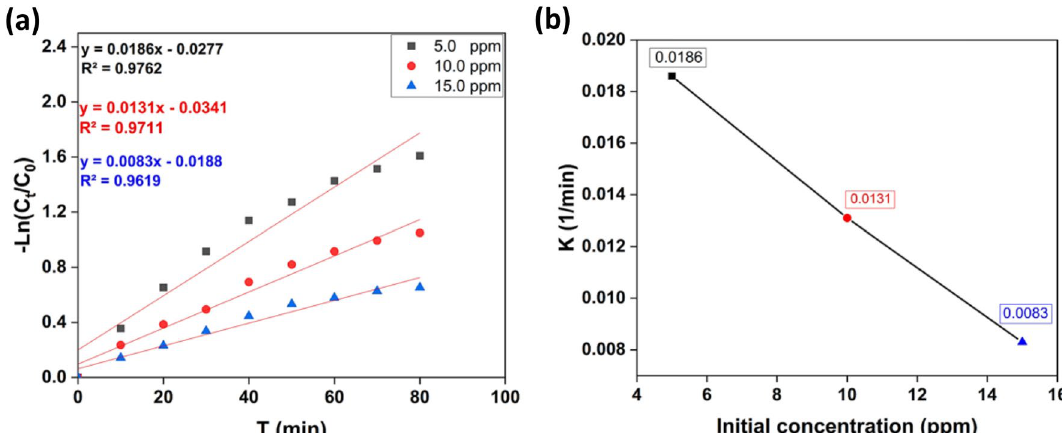
Figure 7. ( a ) Kinetics plots for linear fitting of data obtained from pseudo-first-order reaction model for Congo red degradation under UV light irradiation and 10 mg catalyst, 50 mL (of 5, 10, and 15 mg /L) dye concentration. ( b ) Relationship of apparent pseudo-first-order rate constants and initial concentration of CR.